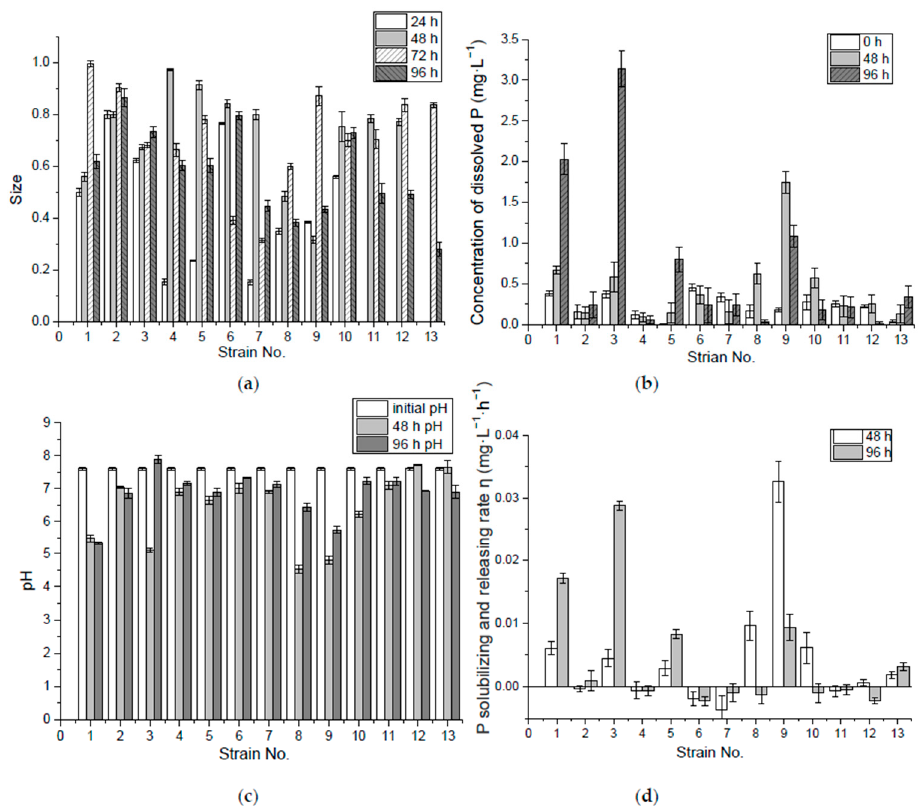
Figure 3. Size of P-solubilizing ring formed by 13 preliminary screened bacteria in the solid medium with lecithin. The microbes were sampled from rhizospheres of Acorus calamus L., and Iris tectorum Maxim. around Tinyin Lake. ( a ) shows that the ring size varying by 24, 48, 72 and 96 h. Concentration of dissolved P ( b ), pH ( c ) and P solubilizing and releasing rate ( d ) by 0 hour, 48 h and 96 h in liquid medium with organic P (lecithin).